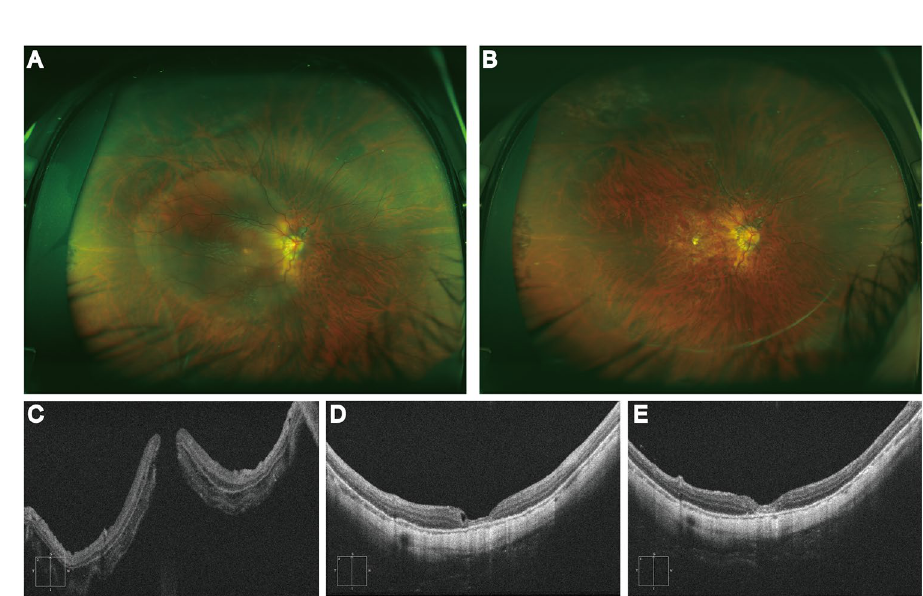
Figure 1. Representative images of inverted multi-layer ILM flap treating MHRD without choroidal detachment. Fundus color photos ( A – B ) and OCT images( C – E ) of a patient in inverted multi-layer ILM flap group before and after operation. MHRD in the right eye ( A ) and retinal reattachment at 3 months after operation ( B ). OCT images showed macular retinal detachment and full-thickness macular hole before